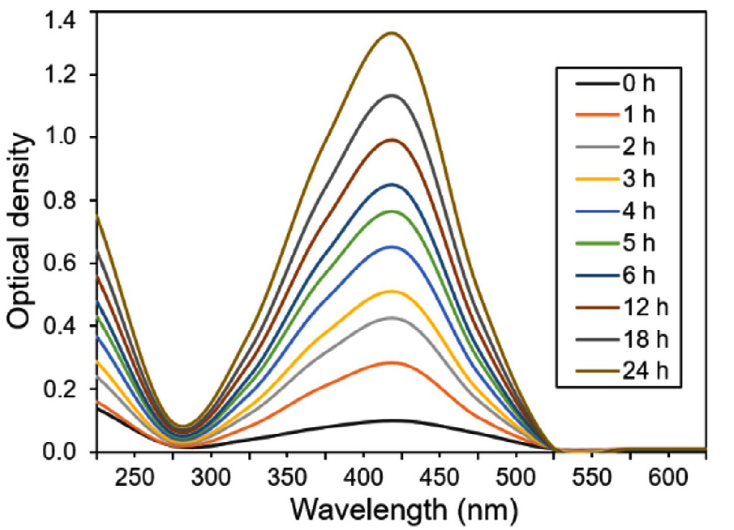
Fig. 1 UV-Vis spectral analysis of in-house engineered silver nanoparticles at numerous intervals within 0 to 24 h range. The λ values were noted from 0 h to each hour until 6 h and then after every 6 h until 24 h by taking an max aliquot from the same mother